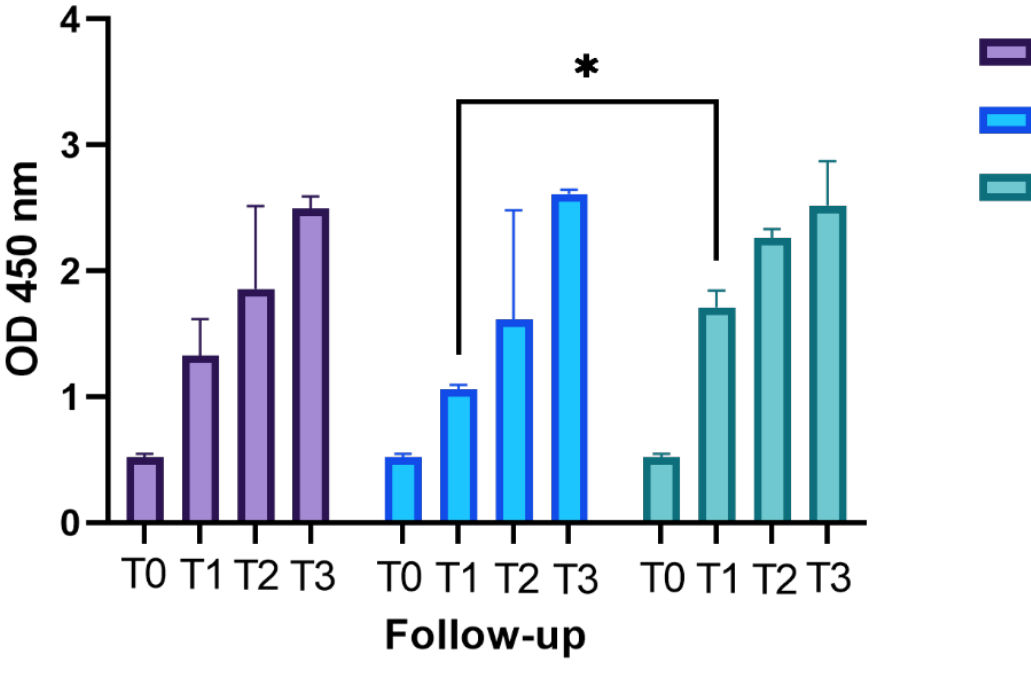
Figure 1. The above separated graph bar shows the grouped data of mean and SD of the OD values (Y-axis) of the cell not exposed to materials (Control) and exposed to the different membranes (X1 and X2) at the different follow-up times (T0, T1, T2, and T3). The * symbol indicates the Bonferroni multiple comparison test which assessed a difference between X1 and X2 at T1 statistically significant. Dunnett’s post hoc analysis did not show a significant variation in the growth curve between the negative control and all experimental membranes from the T0 to T3. The post hoc Bonferroni analysis showed a significant variation in the growth at T1 follow-up between X1 and X2 (Table